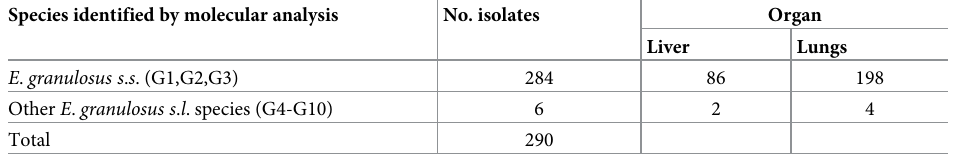
Species identified by molecular analysis No. isolates Organ Liver Lungs E . granulosus s . s . (G1,G2,G3) 284 86 198 Other E . granulosus s . l . species (G4-G10) 6 2 4 Total